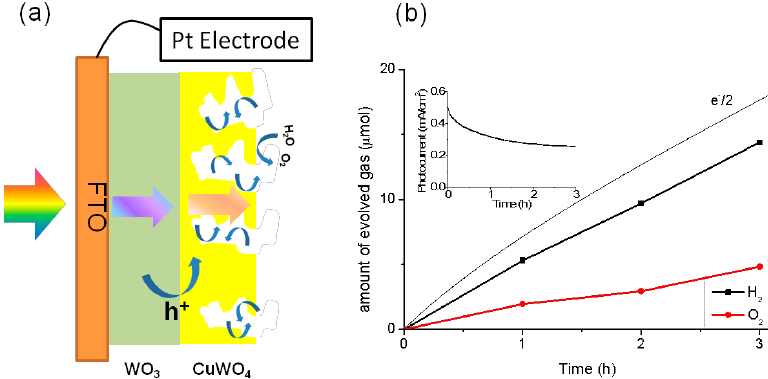
Figure 6. ( a ) Illustration of working mechanism of WO 3 /CuWO 4 composite photoanode; and ( b ) hydrogen and oxygen evolution by WO 3 /CuWO 4 photoanode under AM 1.5 illumination in 0.5